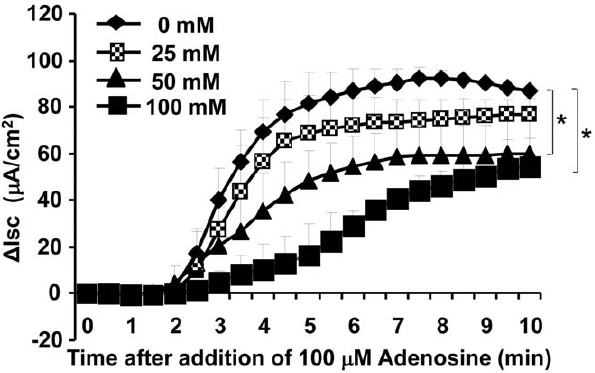
Figure 1. Effect of ethanol pre-exposure on adenosine-induced epithelial ion transport. Calu-3 cells were cultured at an air-liquid interface on membrane filters and basolaterally exposed to 0, 25, 50 and 100 mM of ethanol for 24 hours. These Calu-3 epithelia were placed in an Ussing chamber with asymmetrical buffers of chloride (apical 10.4 mM and basolateral 139.8 mM). Following voltage clamp, stable short circuit baselines were attained in 15 to 20 min. I SC was measured after blocking Na + channels with 100 m M of apical amiloride and stimulated with 100 m M of apical adenosine. Alterations in ion transport are expressed as difference in I SC from their baseline. Ethanol pre- exposure decreased 100 m M adenosine mediated epithelial ion transport in a dose-dependent manner. Asterisks indicate significant differences between groups by One-way ANOVA test ( p , 0.05, n=5 for each